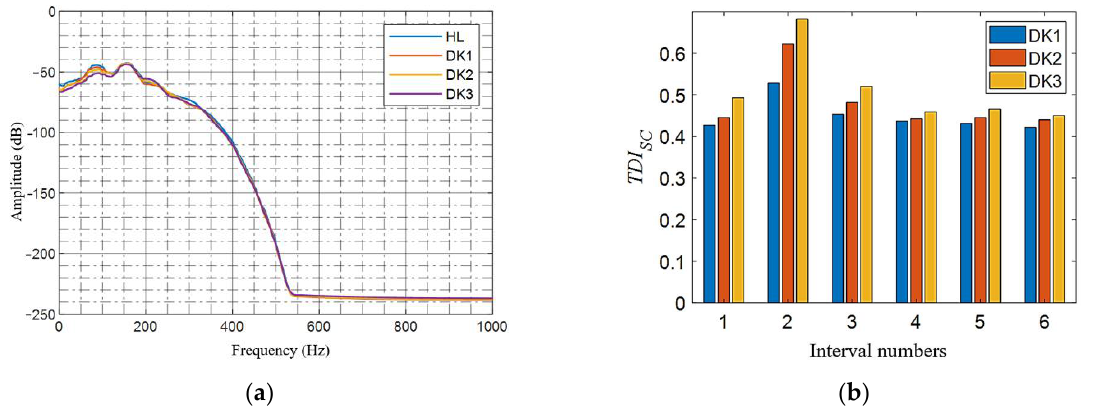
Figure 18. Verification of single stiffness damage in different degrees: ( a ) power spectrum curve of the tunnel acceleration under different degrees of stiffness damage in the second interval and ( b ) TDI SC at different degrees of stiffness damage in the second interval.